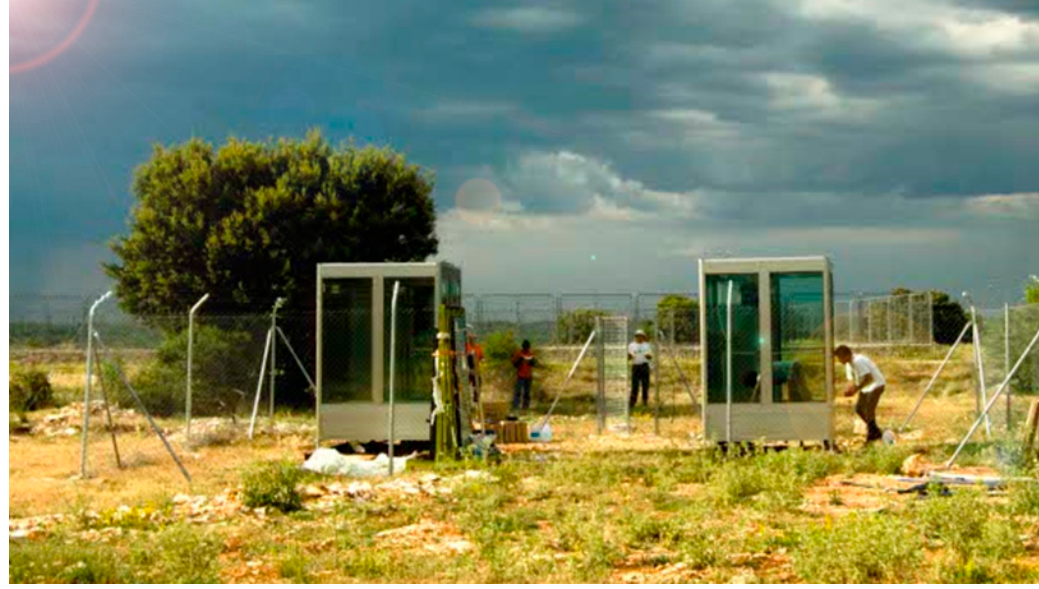
Figure 2. Real prototypes on their location.